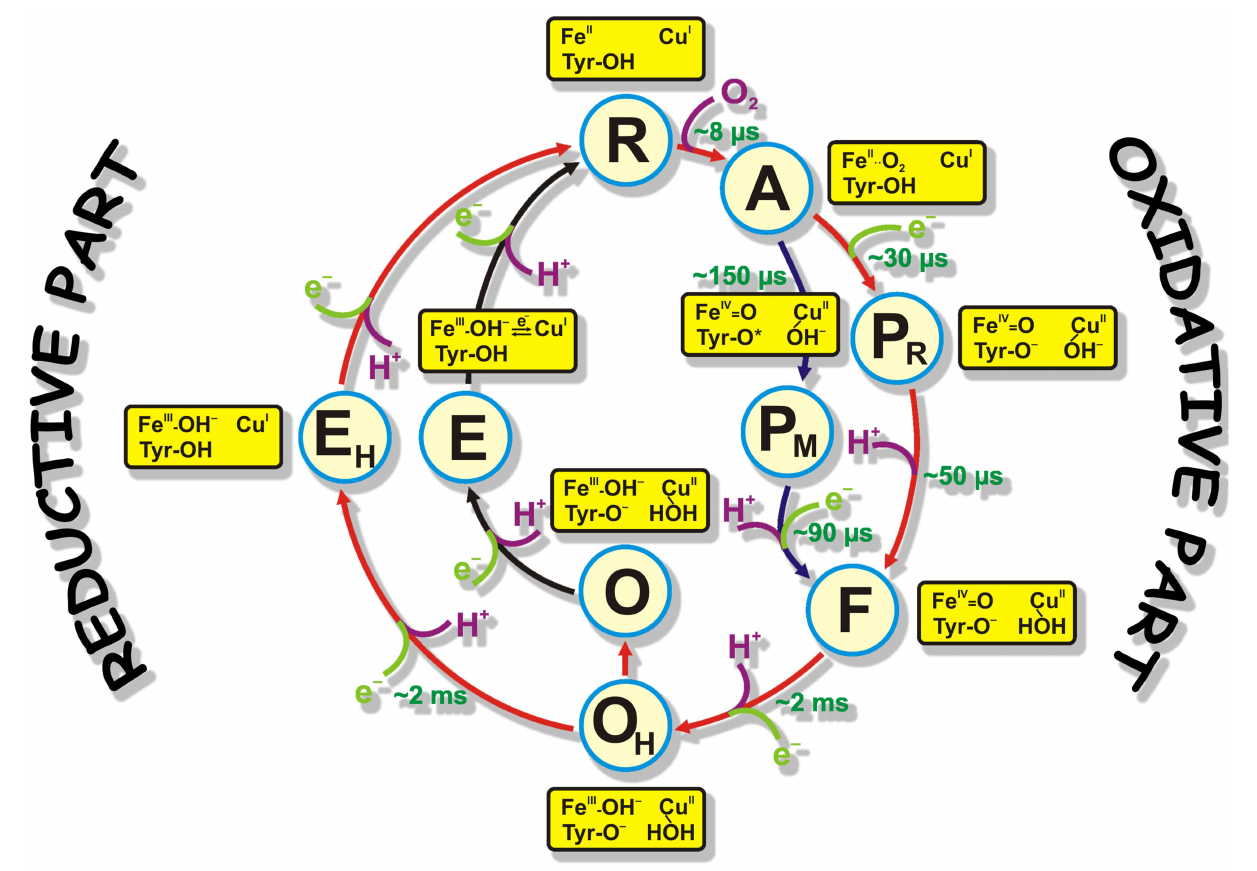
FIGURE 1 | The catalytic cycle of C c O with structures of resolved intermediates. Protons taken by the BNC for the reaction chemistry are shown in magenta. Electrons taken by the BNC are marked in light green. Time constants of the appearance of reaction intermediates are also shown in green. The proposed structures of the catalytic site represent only the BNC structure and provide no information about the other two redox centers (CuA and heme a ).